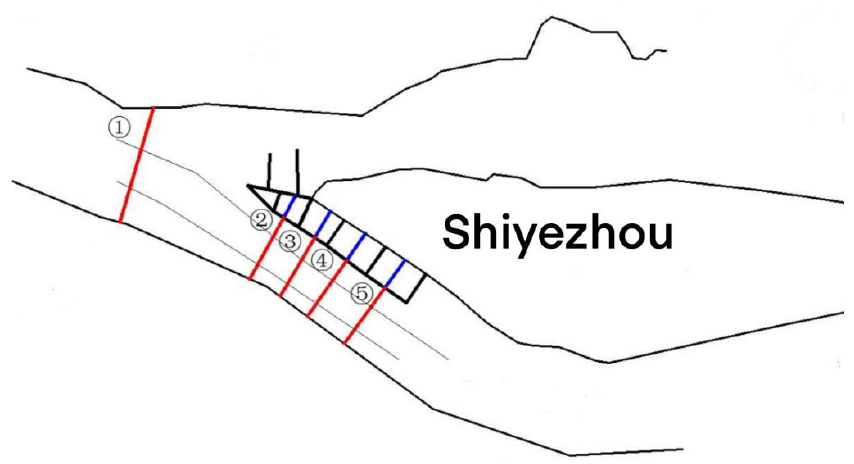
Figure 14. Positions of the sections of Shiyezhou Waterway after the project. Table 6. Equilibrium water depth of the Shiyezhou Waterway after the project.